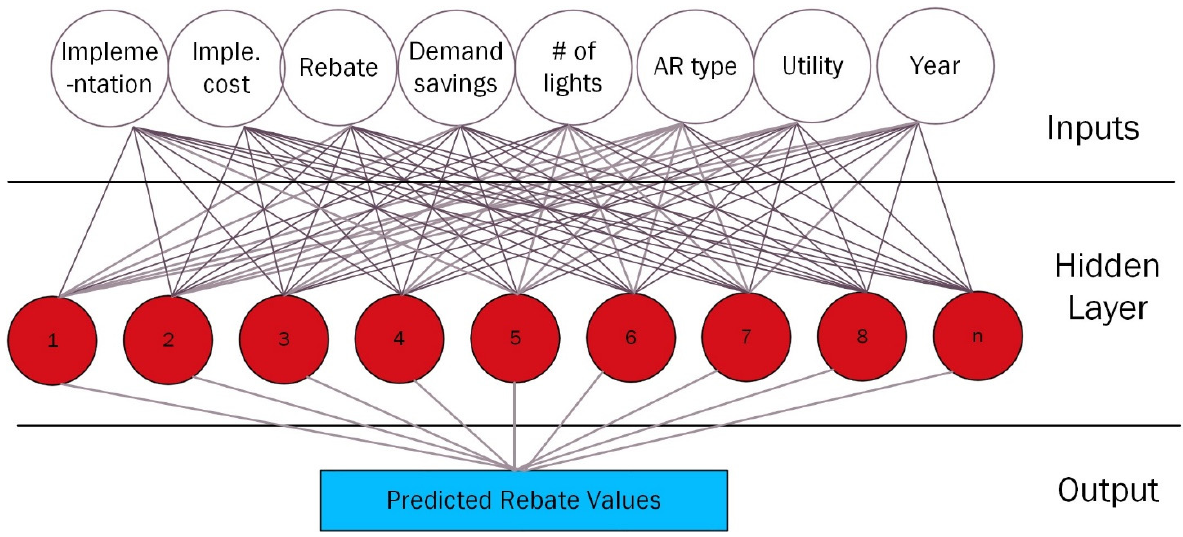
Figure 2. ANN concept applied for the rebate model.